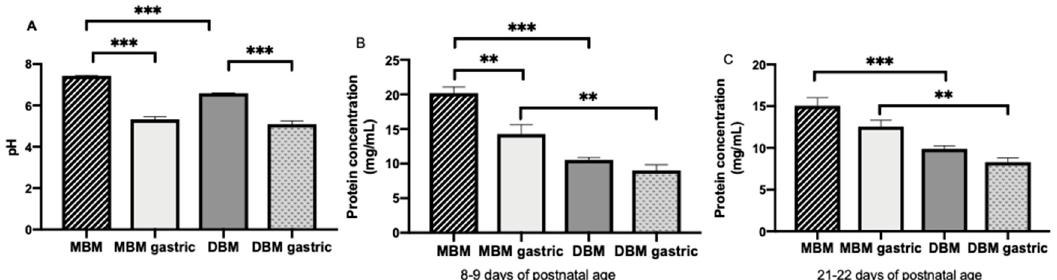
Figure 1. ( A ) pH values of milk and gastric contents at 1-hour postprandial time from 20 preterm infants (26–36 weeks of gestational age (GA)) fed mother’s own breast milk (MBM) and donor breast milk (DBM). Values are mean ± SEM, n = 36 for each group ( n = 20 for 8–9 days and n = 16 for 21–22 days of postnatal age). ( B ) Total protein concentration in milk and gastric contents from infant fed MBM and DBM at 8–9 days ( n = 20) ( C ) Total protein concentration in milk and gastric contents from infant fed MBM and DBM at 21–22 days ( n = 16). Asterisks show statistically significant differences between variables (*** p < 0.001; ** p < 0.01) using the Wilcoxon matched-pairs signed-rank test.